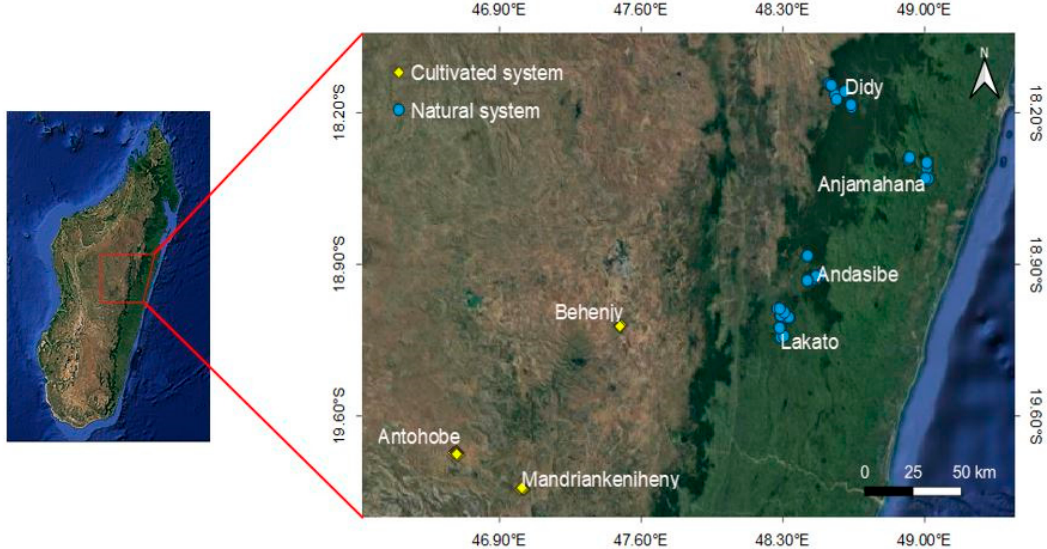
Figure 1. Spatial distribution of site for sampling. Cultivated system samples were from the Vakinankaratra region and natural system samples were from eastern Madagascar. Table 1. Spatial characterization of the soil sample used for the study.